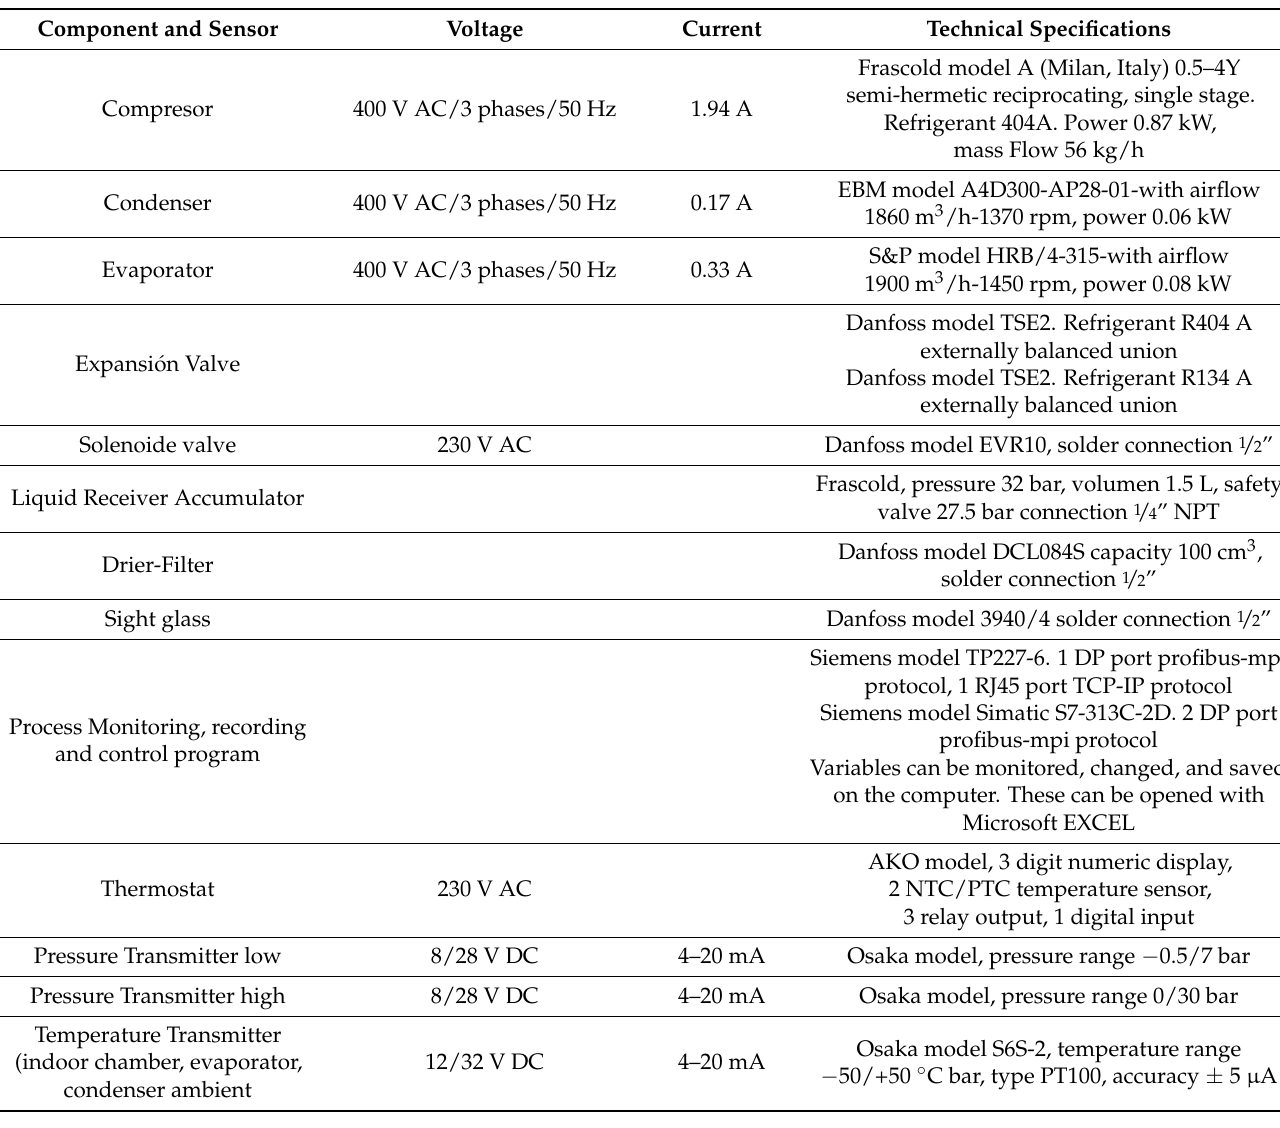
Table 1. Specification of the refrigerating